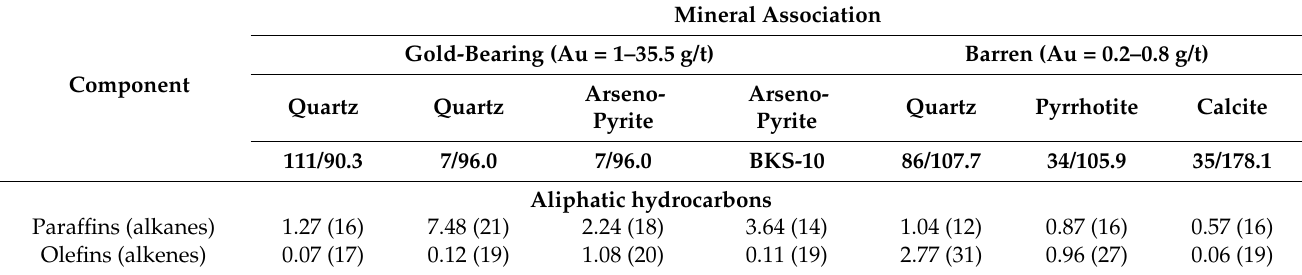
Table 3. Content (rel.%) and number (in parentheses) of volatiles extracted by mechanical shock crushing of minerals from the Blagodatnoye deposit (according to